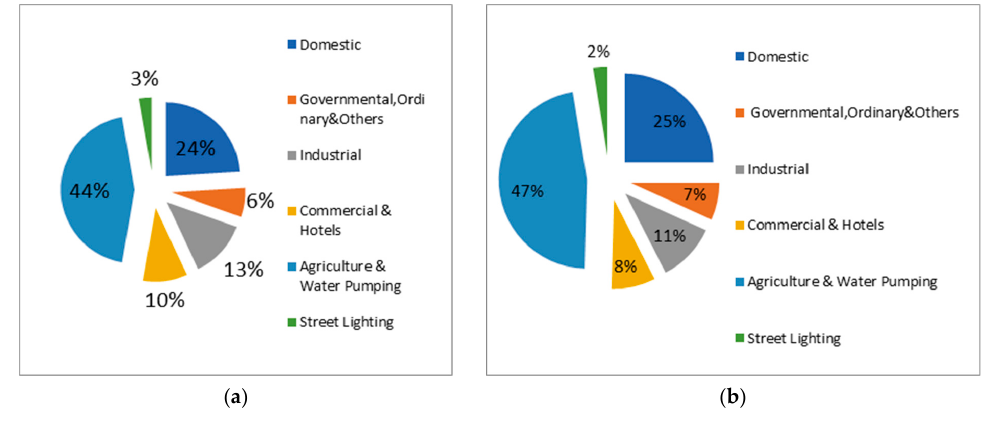
Figure 17. EDCO’s electricity consumption by sector. ( a ) 2019, ( b ) 2020. The percentage change in the monthly demand at EDCO’s area between 2019 and 2020 along with the stringency index is shown in Figure 18. As can be seen from the figure,